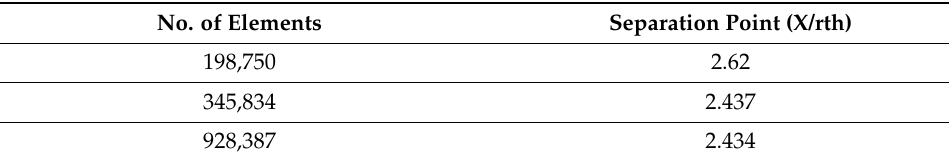
Figure 2. Block-structured grid of the DLP-PAR nozzle used for NPR 14. Table 3. Grid independence